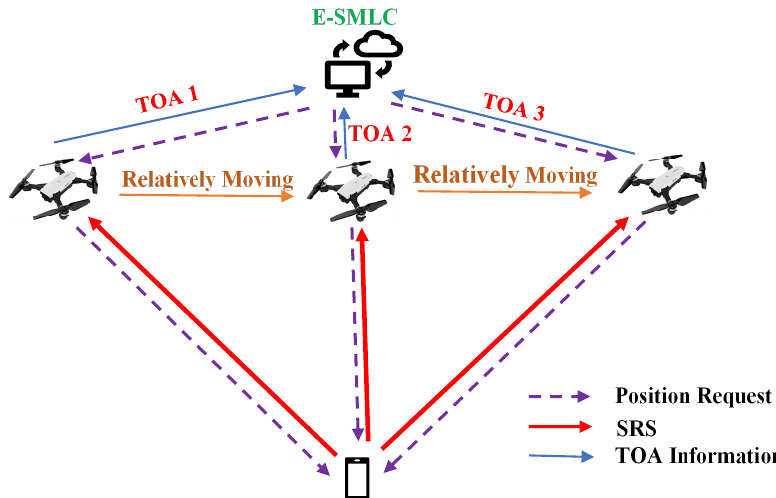
Figure 11. Signal transmission of the proposed UTDOA by